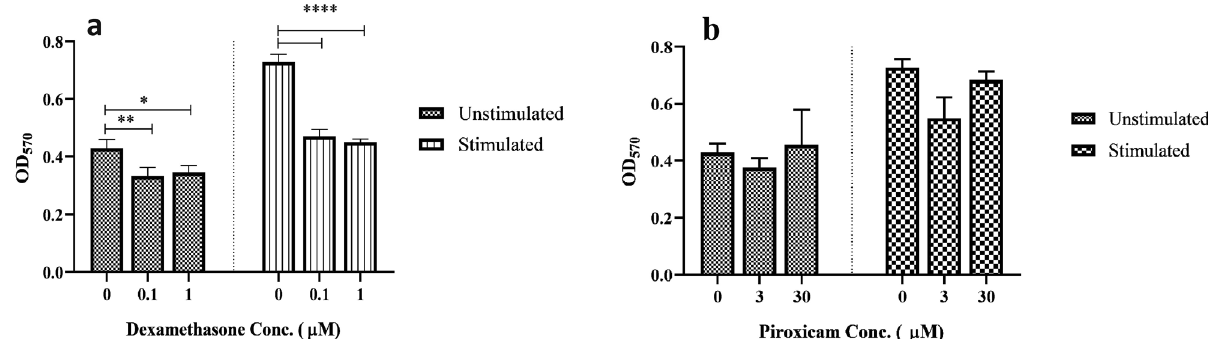
Figure 2. The effect of drugs on the proliferation of T cells in PBMCs in stimulated and non-stimulated conditions. The effect of two different concentrations of dexamethasone ( a ) and piroxicam ( b ) on the proliferation of T cells in PBMCs was compared in stimulated and non-stimulated conditions (n = 3). The graphs show the mean ± SD. Significant changes are indicated with asterisk (* p < 0.05, ** p < 0.01, *** p < 0.001, **** p <